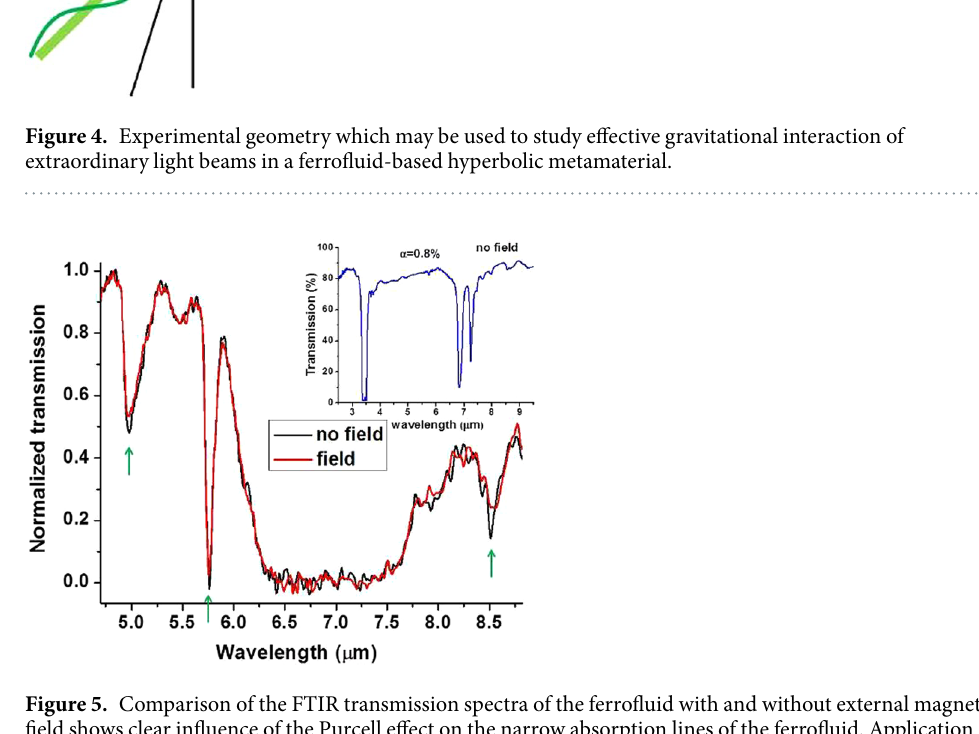
than others to sustain the excited states of these species. Thus, the ferrofluid-based metamaterial “multiverse” may be used to illustrate the fine-tuning mechanism in cosmology. The Purcell effect is the enhancement of a fluorescent molecule’s spontaneous emission rate by its environ- ment, which is determined mainly by the enhancement of the photonic density of states. According to the Fermi’s golden rule, the transition rate between the excited and the ground state of an atom or molecule is proportional to the density of final states: